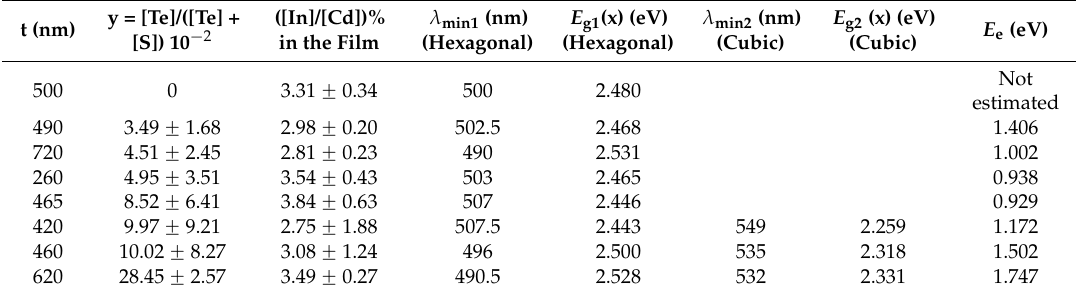
Table 2. The values of the wavelength at the minima from Figure 7, estimated values of the bandgap energies for different values of y, film thickness, and the estimated values of the Urbach tail width E e .